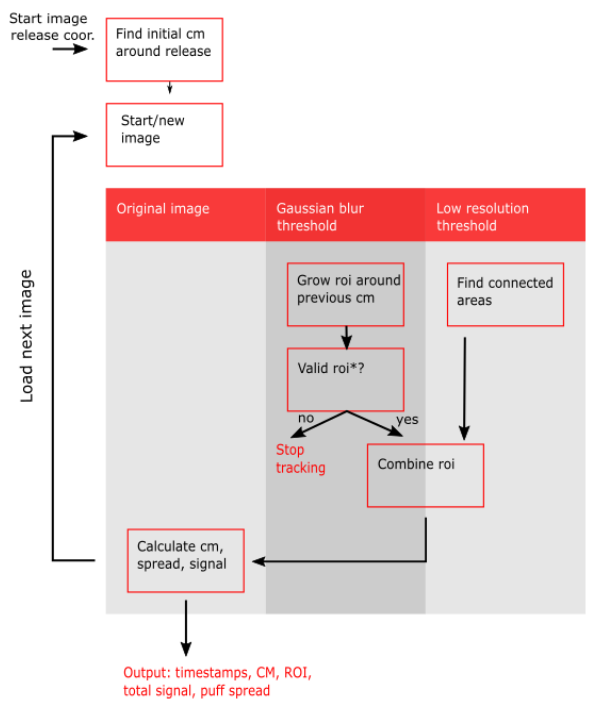
Figure B1. Flow diagram of the tracking algorithm. The puffs are detected iteratively based on the previous detection and two noise- reduced versions of the original image. The conditions for a valid ROI can be found in the